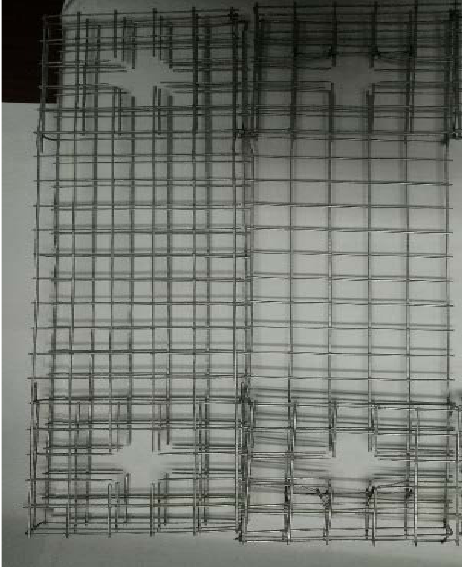
Figure 2. Double-layer ( left ) and single-layer ( right ) steel grids used in the current study.